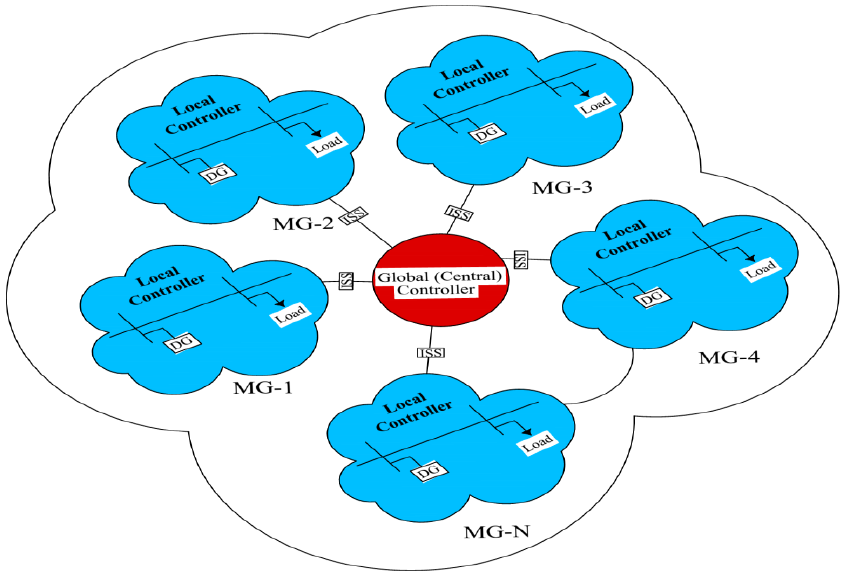
Figure 2. Networked central controlled distributed system with five micro-grids.